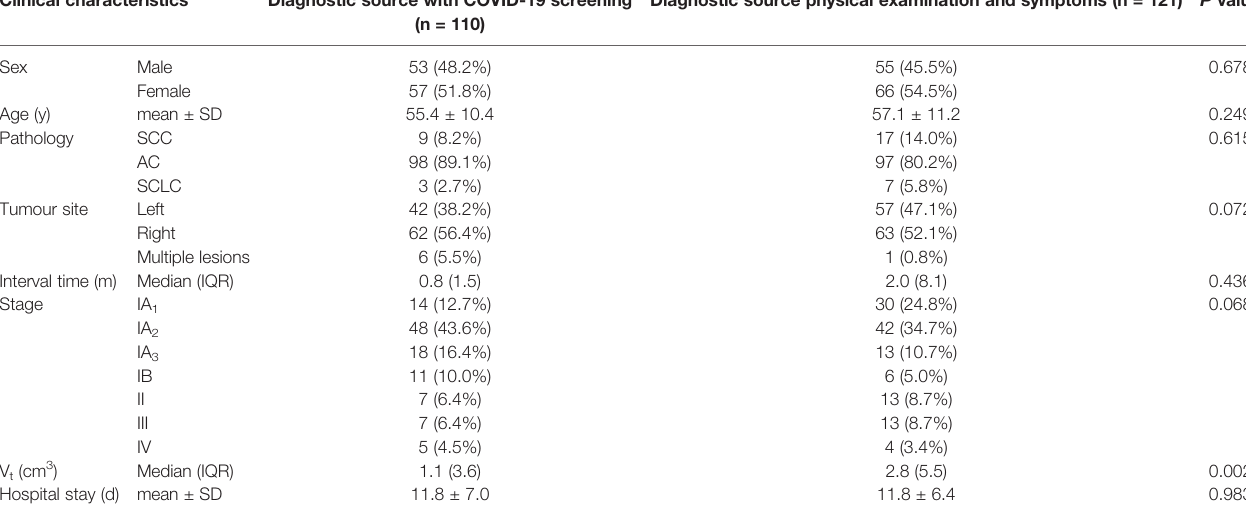
TABLE 2 | The clinical characteristics of epidemic subgroup. Clinical characteristics Diagnostic source with COVID-19 screening